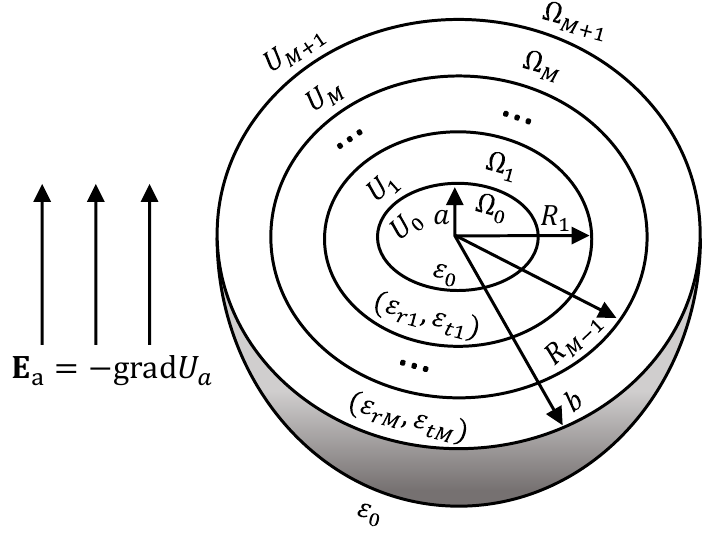
Figure 1. Schematic representation of an externally applied electric field E a and the multilayer spherical shell ( Ω , ε ) , immersed in free